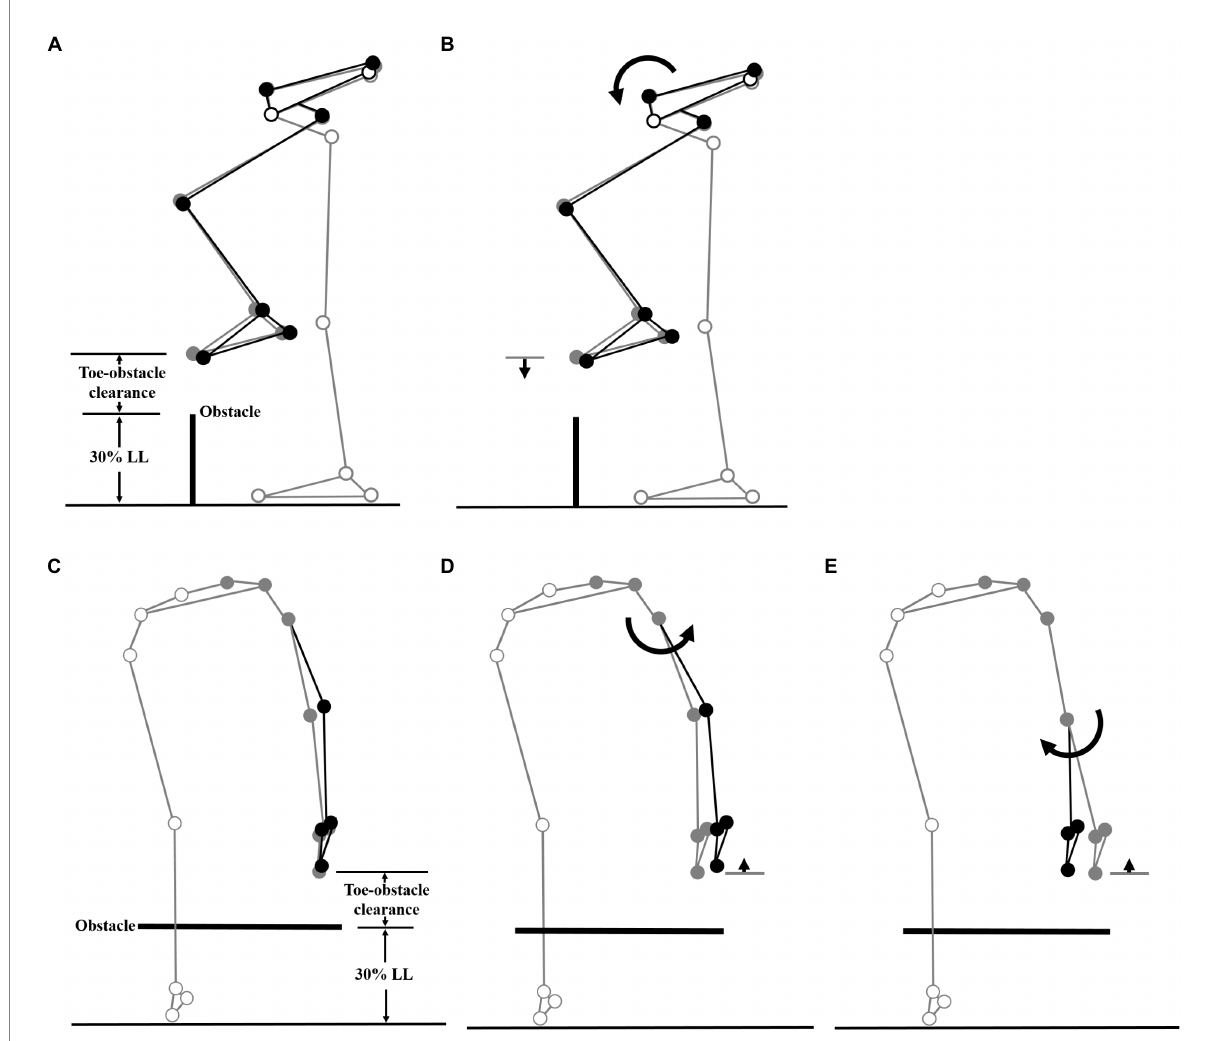
FIGURE 3 Effects of the observed significant angular changes at individual joints on the leading toe-obstacle clearance in the MCI group (black stick figure) compared to Control ( A and C , grey stick figure) when the leading toe was above an obstacle of 30% LL in height. The stick model was drawn using marker positions of a typical subject from each group. The segments with solid grey circles are joints of the reference limb. With the stance foot fixed to the ground, only one joint was rotated at a time according to the mean angular change reported in Tables 3, 4, while keeping the angles of the other joints fixed, and the segments of the stance limb and the segments of the swing limb distal to the current joint stationary. The MCI group showed increased pelvic anterior tilt (B) , and increased hip abduction (D) and knee adduction (E) in the swing limb. As indicated by the black stick figure, while (D,E) tended to increase the leading toe-obstacle clearance, (B) gave the opposite effect, leading to the observed normal toe-obstacle clearance. Note that the stick figures were drawn based on the statistical results of the averaged values of both limbs reported in Tables 3,